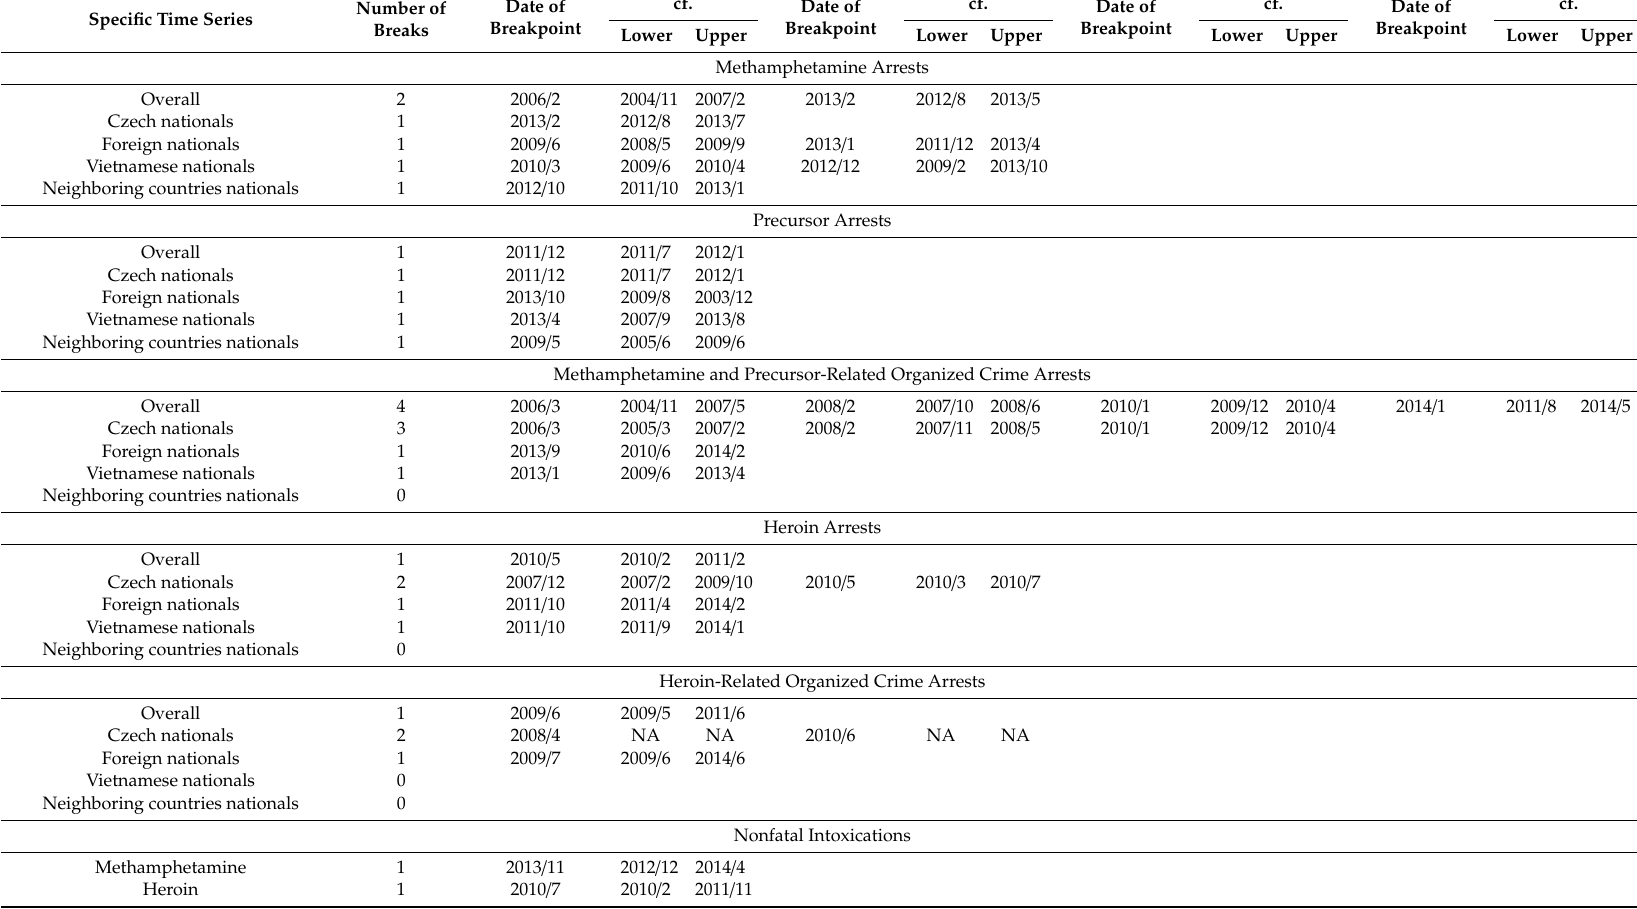
Table 1. The structural breaks identified in time